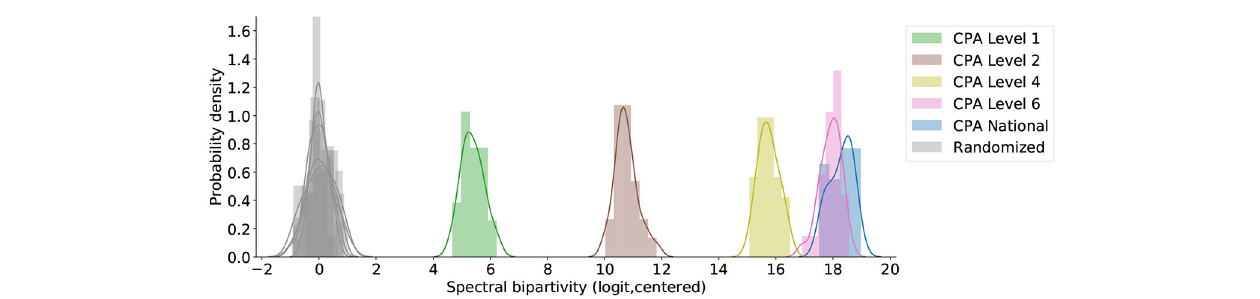
FIGURE 5 | Values of logit-transformed spectral bipartivity for simulated networks of trade-compatible relationships and their randomized comparisons, centered by the median comparison value. Layers are designated according to the European CPA (2008) and its Dutch implementation, which is the most detailed.